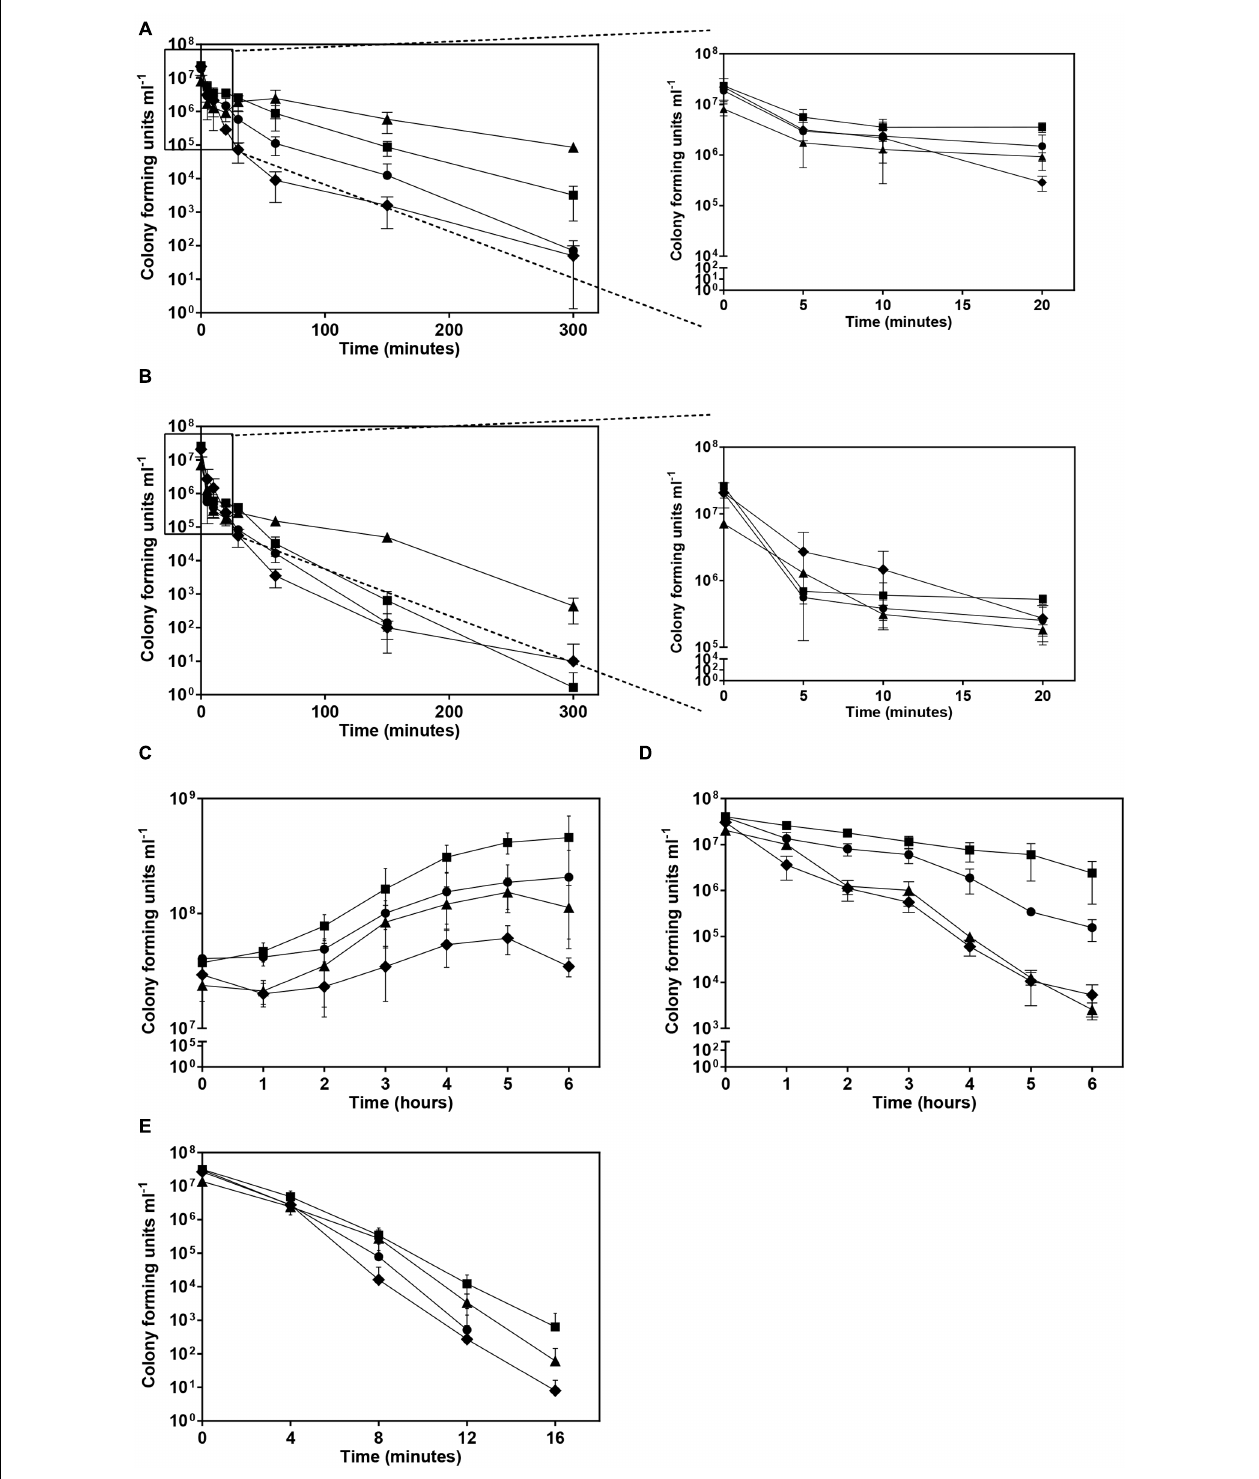
FIGURE 5 | Effect of different stresses in the viability of the cultures of four B. cenocepacia sequential clonal variants examined. Cultures of the four isolates under study, IST439 ( (cid:78) ), IST4113 ( (cid:4) ), IST4129 ( (cid:7) ) and IST4134 ( ) cultivated in the absence of stress were exposed to different stresses, namely osmotic (saline) stress using 2M NaCl (A) or 3M NaCl (B) , heat stress at 42 ◦ C (C) or 44 ◦ C (D) , and oxidative stress using 0.01% hydrogen peroxide (E) . Error bars represent (cid:32) standard